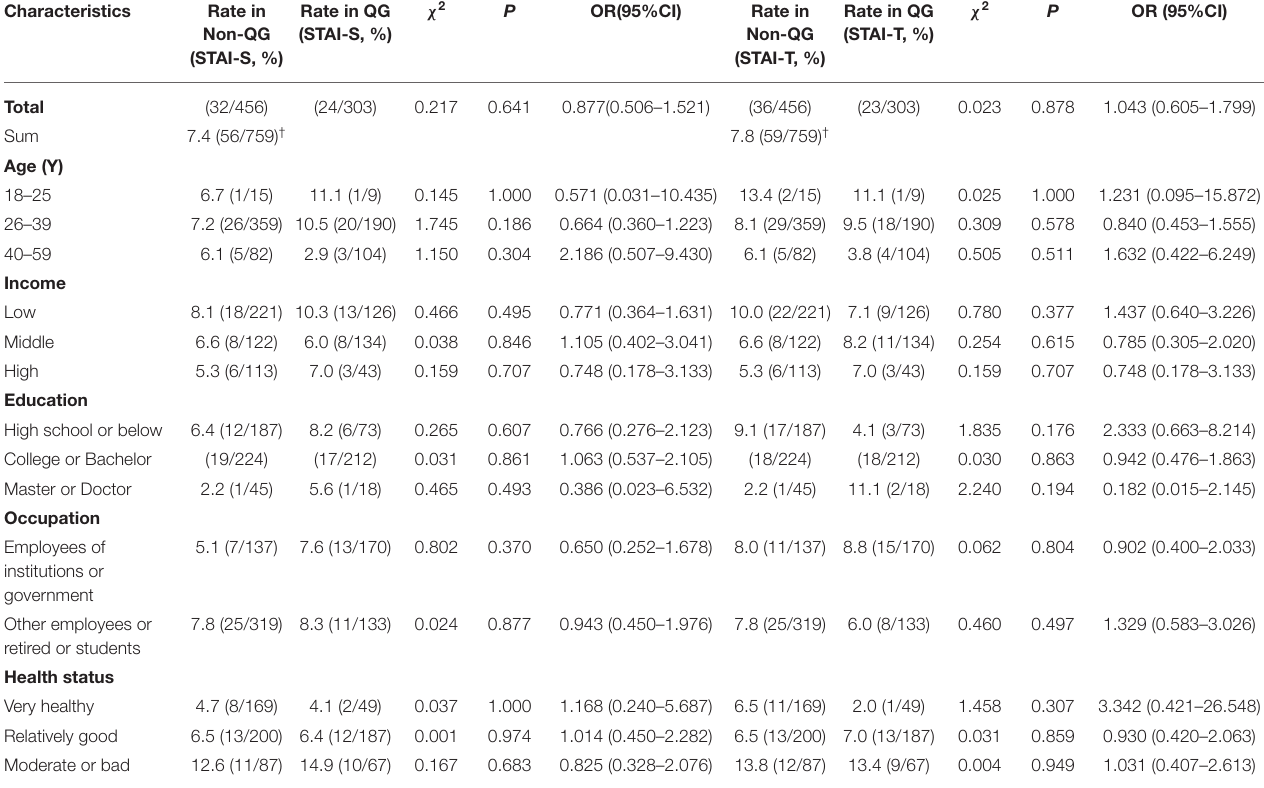
TABLE 2 | Comparison of rates of severe anxiety between the quarantined and non-quarantined groups.